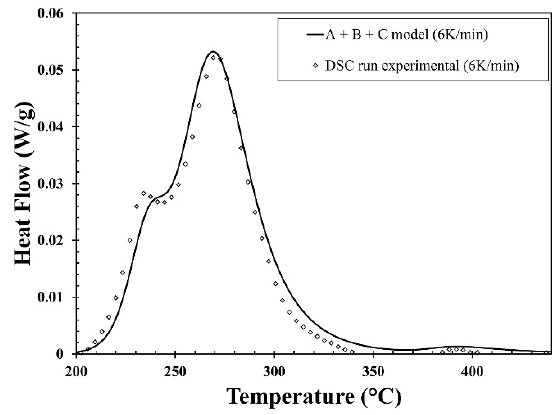
Figure 4. Kissinger diagrams for AlSi7Cu3.5Mg0.15 (Mn, Zr, V) alloy: ( a ) Peak A, ( b ) peak B, ( c ) peak C.